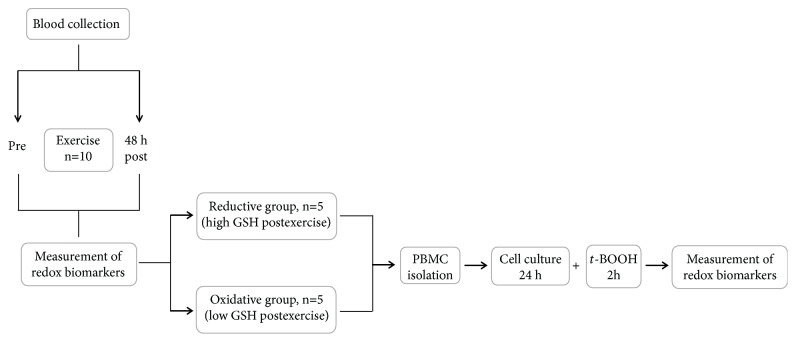
The study design.